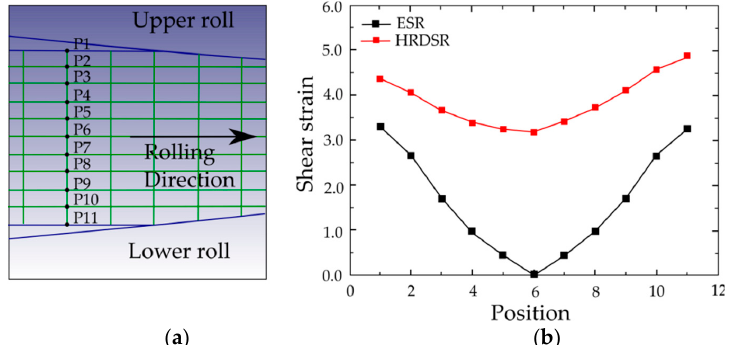
Figure 8. ( a ) The analyzed points in the enmeshed domain of simulation and ( b ) the accumulated shear strain along the thickness of the sheet using finite element simulation for HRDSR with SR = 3 for a thickness reduction of 70% by a single pass [46]. Reproduced with permission from Kim et al., Mater. Sci. Eng. A ; published by Elsevier, 2013.